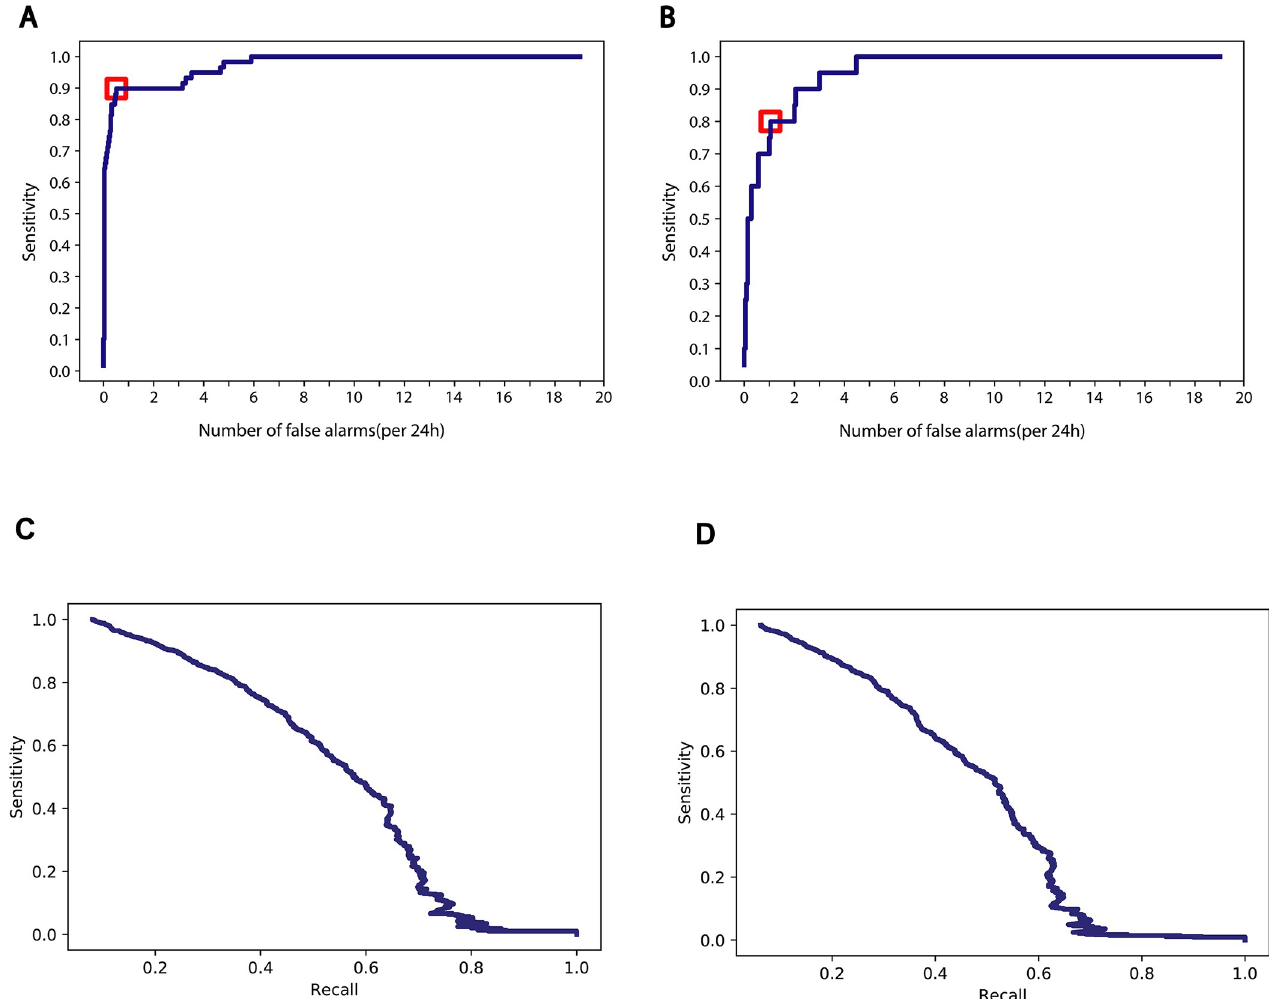
Fig 5. Performance of the machine learning model. ( A ) ROC curve of 10-fold leave-one-seizure-out cross-validation on 66 patients, the threshold is marked in red. ( B ) ROC curve of real-time testing on recorded seizure events of 11 selected subject in the validation cohort, the threshold is marked in red. ( C ) Precision-Recall curves of the prediction accuracy. ( D ) Precision-Recall curves of the validation